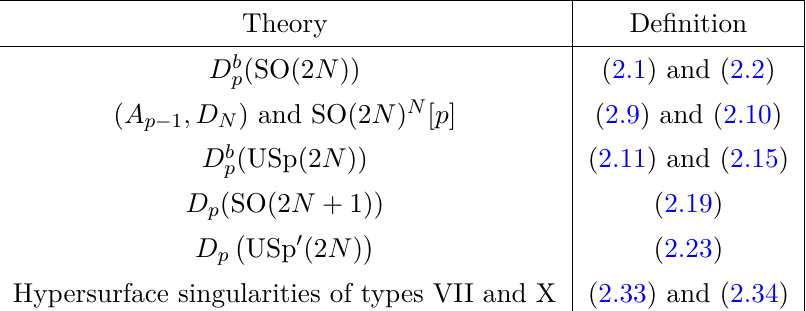
Table 1 . Summary of the 4 d theories studied in this paper with the reference to their